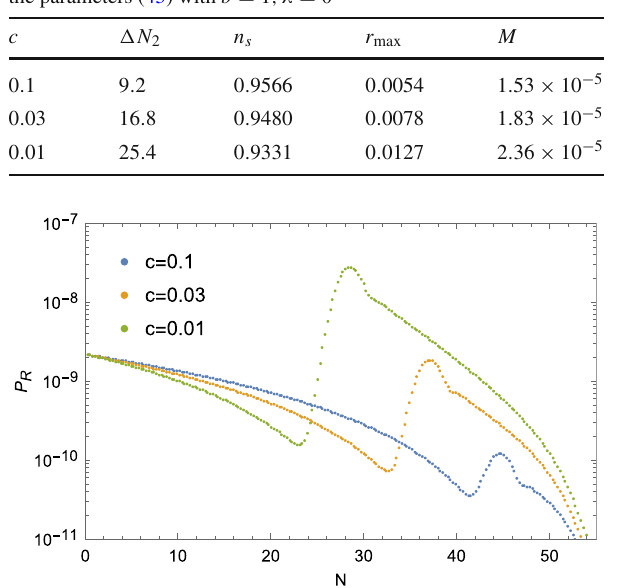
Fig. 9 The power spectra P R of scalar perturbations with the param- eters (45). The horizontal axis shows the e-folds number when the cor- responding mode k crosses the horizon